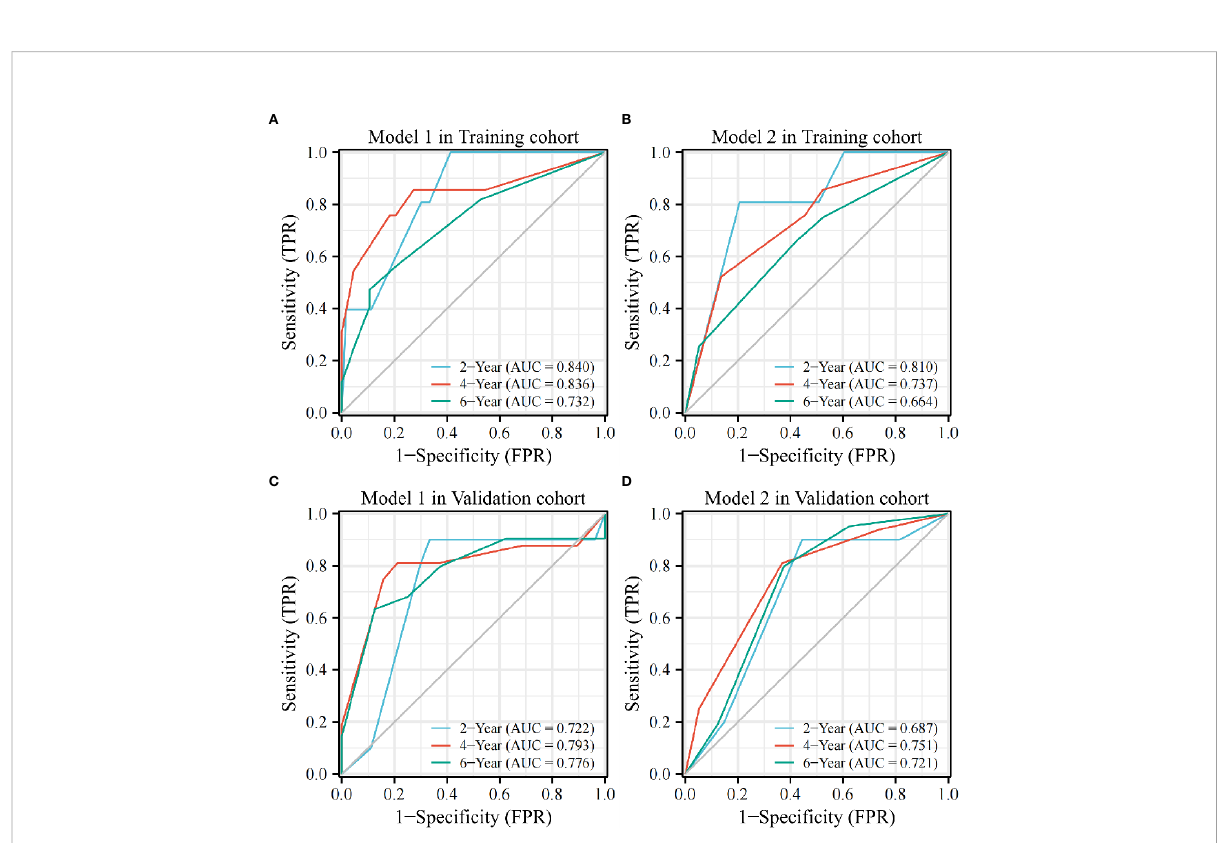
FIGURE 3 The AUC value of Model 1 is higher than that of Model 2 at 2, 4, and 6 years in the training (A, B) and validation cohorts (C, D) .AUC, area under the curve; TPR, true positive rate; FPR, false positive